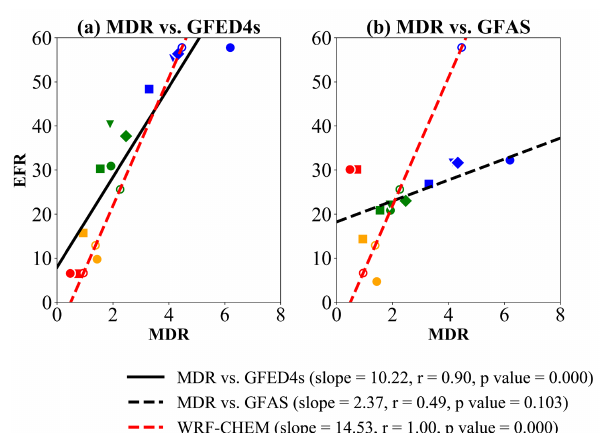
Figure 7. The relationship between the average MDR and EFR from GFED4s is shown in panel (a) and between the average MDR and EFR from GFAS in panel (b) . The different colored symbols corre- spond to regions listed in the legend of Fig. 6a. The linear regression derived from the MDR-EFR data is shown for both panels (black solid and dashed lines). The MDR-EFR relationship from the four WRF-Chem simulations is shown by the colored open circles, and the linear regression through these four markers is shown by the red dashed line. The slope, Pearson correlation coefficient and two- sided p value (for a hypothesis test whose null hypothesis is that the slope is zero) are reported for each regression